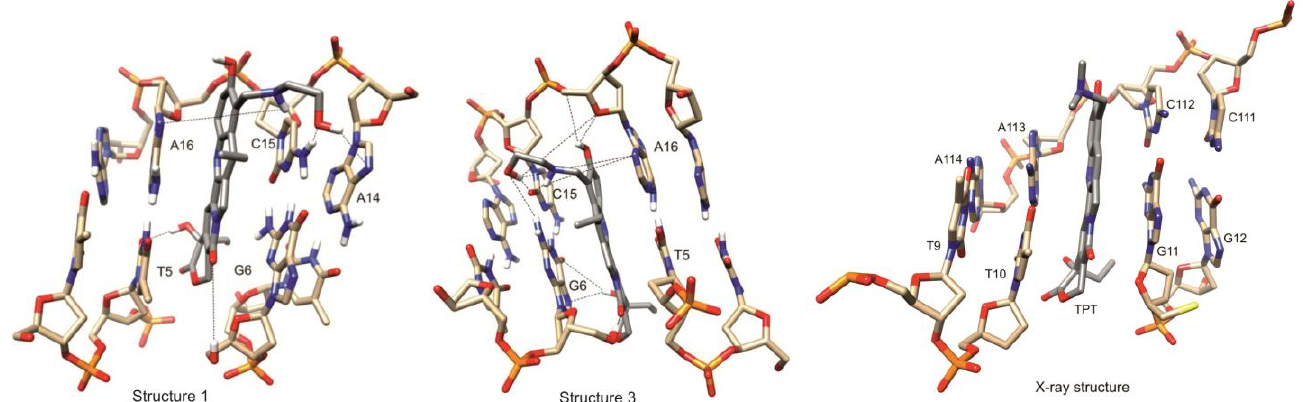
Figure 4. Structures representing the main clusters for family structures 1 and 3. Dotted lines indicate a possible hydrogen bond network stabilizing the structure. For clarity, only two base pairs flanking the nick are shown. Right panel shows the snapshot from the X-ray complex of nicked 20-mer DNA with topotecan